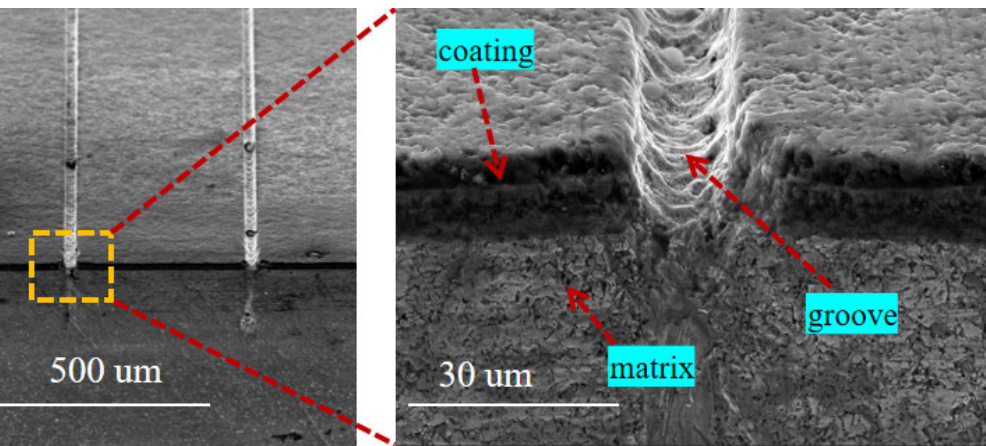
Figure 5. The SEM of the cross-sectional image of the groove structure was processed (laser pulse energy is 10 μJ, the scanning speed is 0.7 mm/s and the scanning number is 5).